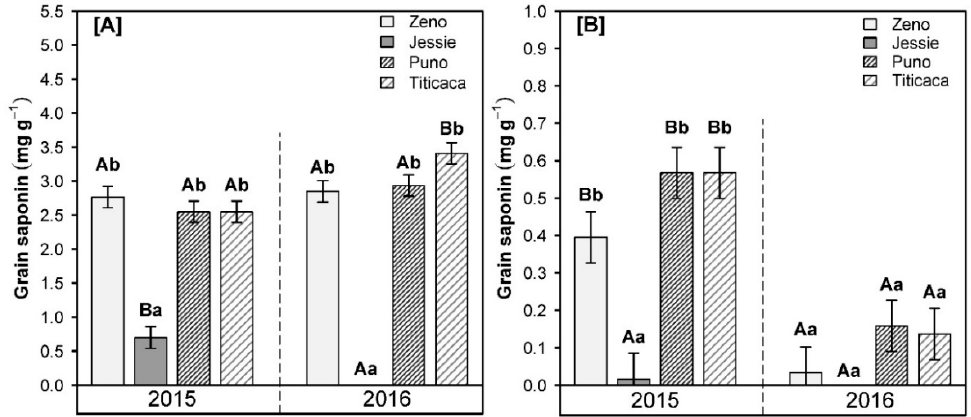
Figure 5. Saponin (mg g − 1 ) content of non-polished ( A ) and polished ( B ) grains for the two years and four quinoa cultivars (Zeno, Jessie, Puno, Titicaca). Within year, bars headed by the same lowercase letter are not significantly different ( p < 0.05). Capital letters compare the two years for the same cultivar, bars headed by the same letter are not significantly different ( p < 0.05). Error bars indicate the standard error of the mean. Notice the change in vertical scale between the figures.